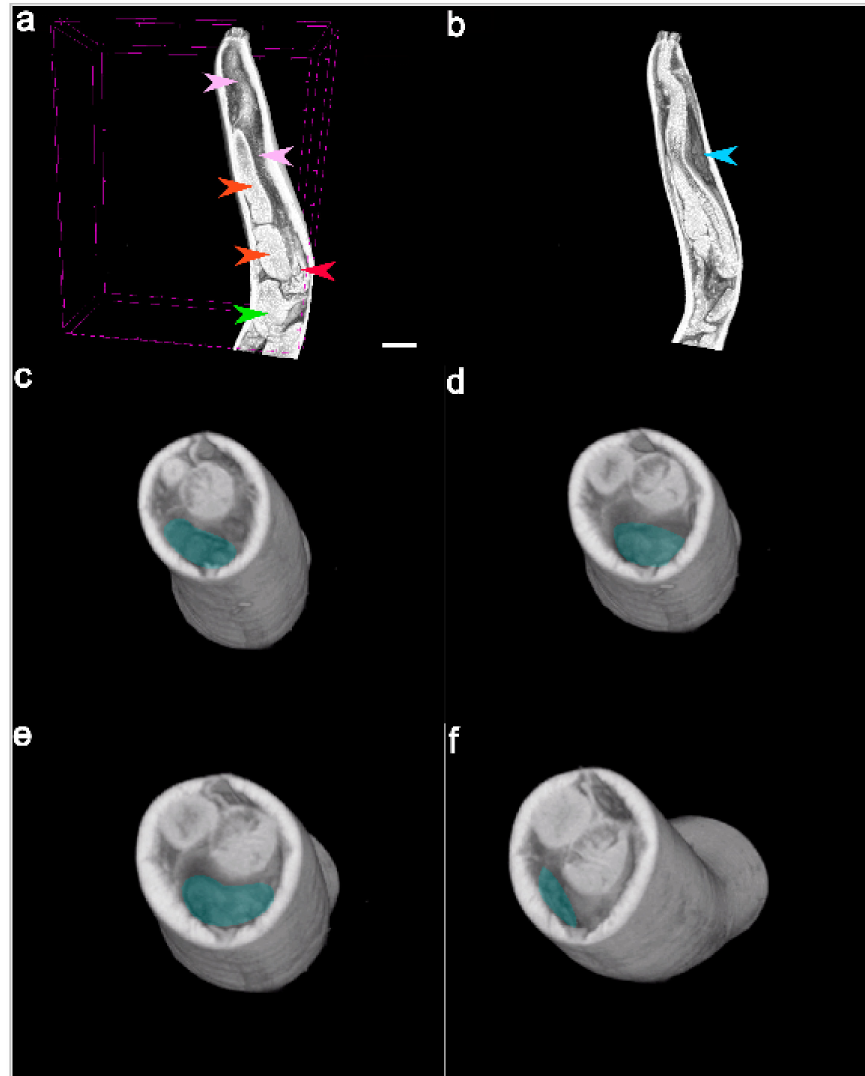
Figure 5. Representative longitudinal 2D ( a , b ) and transversal 3D ( c – f ) renderings of the adult Pseudoterranova azarasi forebody, with the excretory cell (EC) overlaid in blue color and arrows showing esophagus (pink), intestinal caecum (orange), ventriculus (red), intestine (green), and EC (blue). Scale bar: 500 µ